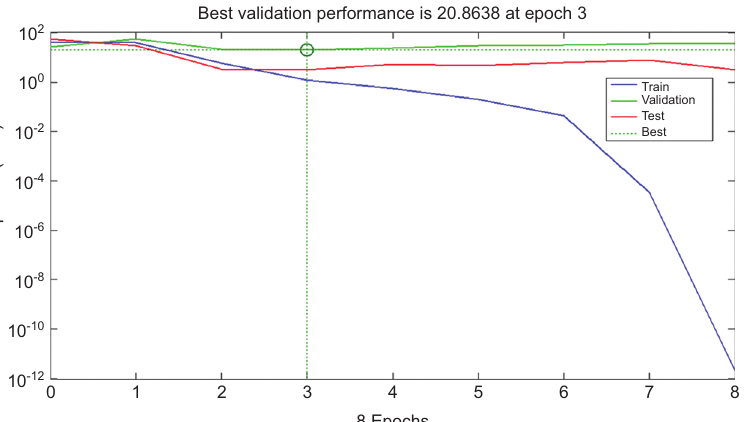
nanofluid for the zeta poten- 2